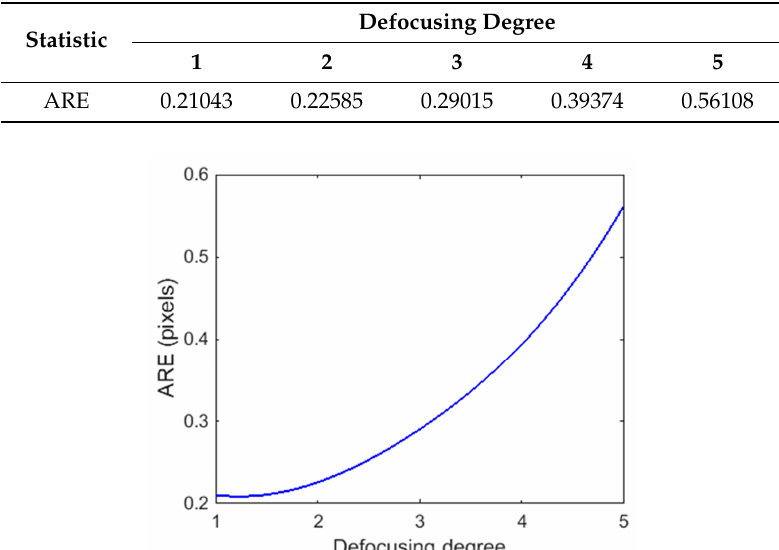
Figure 7. The ARE of a projector under different defocusing degrees.